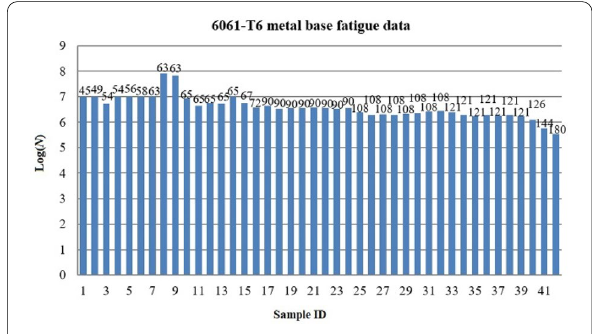
Figure 11 6061-T6 metal base fatigue data